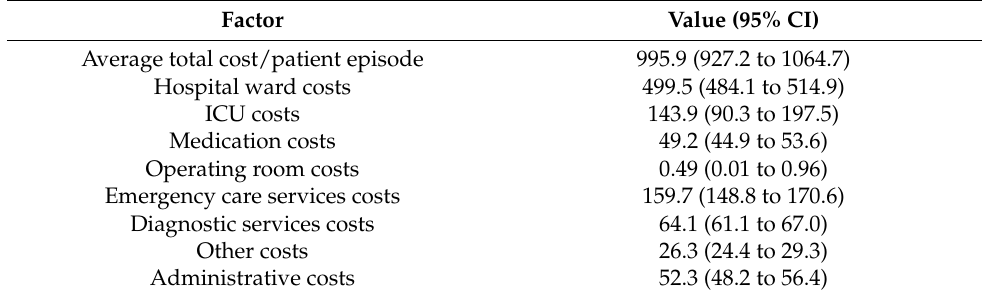
Table 3. Cost structure (EUR) of CHF inpatient